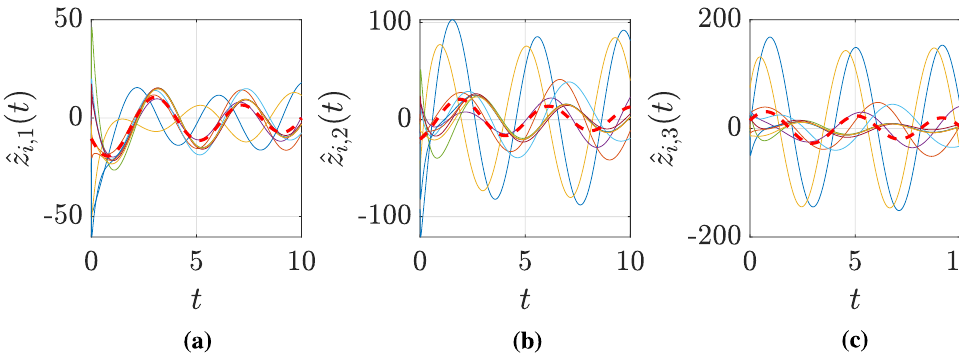
Figure 9. Consensus results for the linear protocol with ∆ = 10 − 4 , ε = 0, showing the estimates of the derivatives of first ( a ), second ( b ), and third ( c ) order. The derivatives ¯ z ( 1 ) ( t ) , ¯ z ( 2 ) ( t ) , ¯ z ( 3 ) ( t ) are plotted as a dashed red line. High-order derivatives are not accurately computed using a linear protocol.